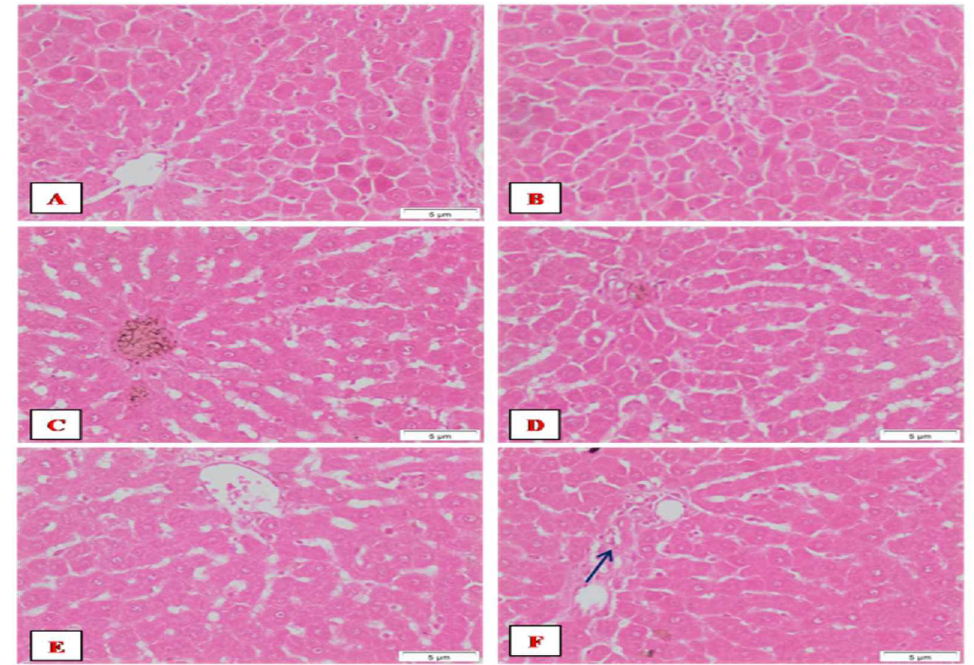
Fig 5. Photographs of liver sections stained with H & E. (A and B) Doxorubicin-treated rats showing a focal of enlarged cells with mild inflammatory infiltration, respectively. (C and D) 1,8 Cineole-treated rats were showing the ordinary structure of the hepatic lobule and portal area, respectively. (E and F) Dox+Cin treated rats showing the ordinary structure of the hepatic lobule with mild inflammatory infiltration, respectively.